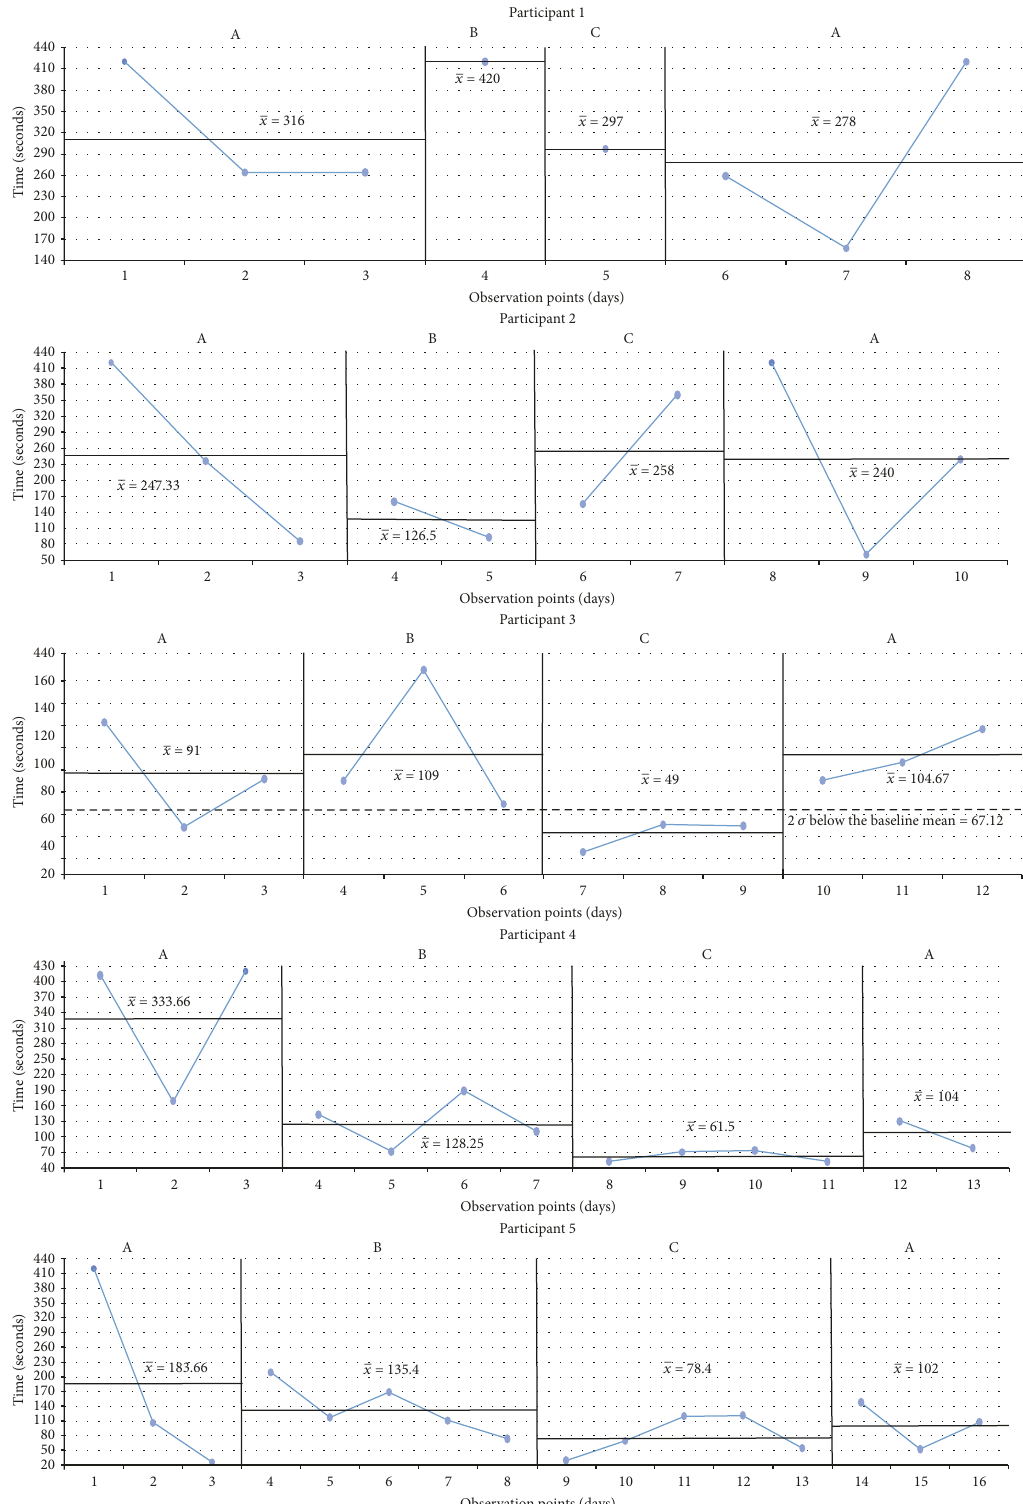
Figure 2: Sorting bugs. A: baseline; B: sham tDCS; C: tDCS; x -axis: observation points in days; y -axis: completion time in seconds. Scores are shown, along with black lines marking the average of each phase and with a black dotted line starting at the corresponding baseline marking 2-standard deviation (2 σ ) when there is statistically signi fi cant di ff erence (participant